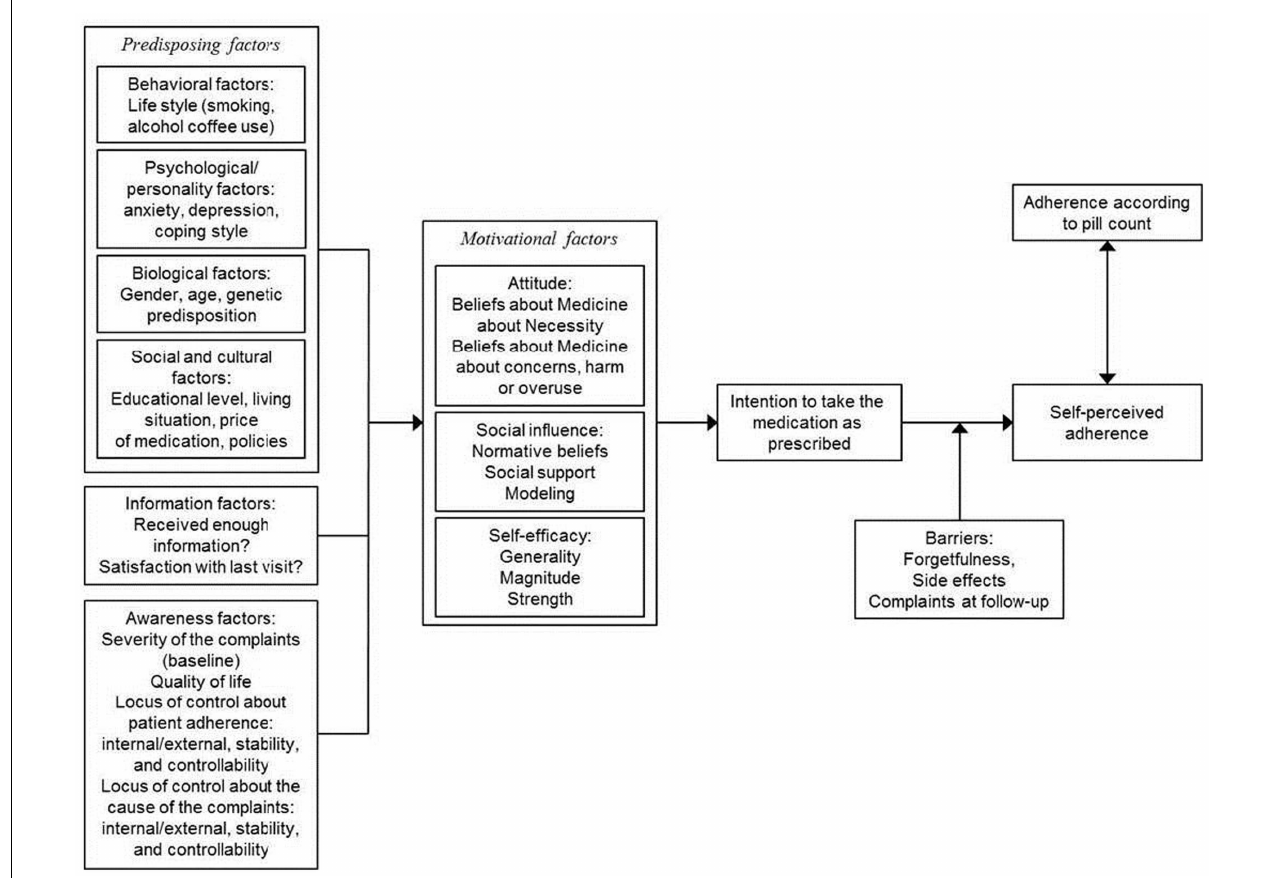
adherence to prescribed dyspepsia medication?” by Fransen et al. (2009). Copyright 2009 by G. A. J. Fransen. Reprinted with